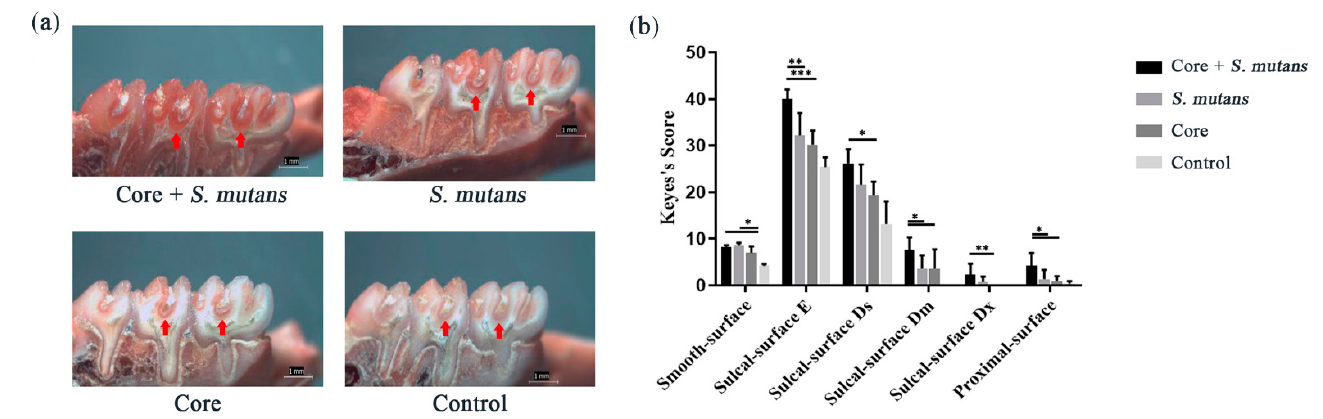
Figure 4. In vivo cariogenesis ability of different biofilms. ( a ) Representative hemisectioned molars in each group under stereoscopic microscopy. ( b ) Caries score by Keyes’ method (n = 5). E = Enamel caries; Ds = slight dentinal caries; Dm = moderate dentinal caries; Dx = extensive dentinal caries. The severity decreased in the order of Core + S. mutans , S. mutans , Core and control groups. * p < 0.05; ** p < 0.01; *** p < 0.001.